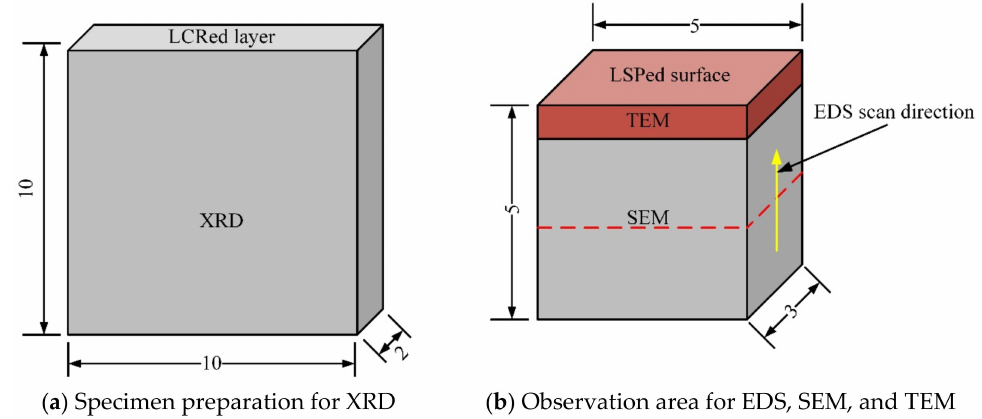
Figure 3. Schematic diagrams of the samples and observation areas used for the various test methods.